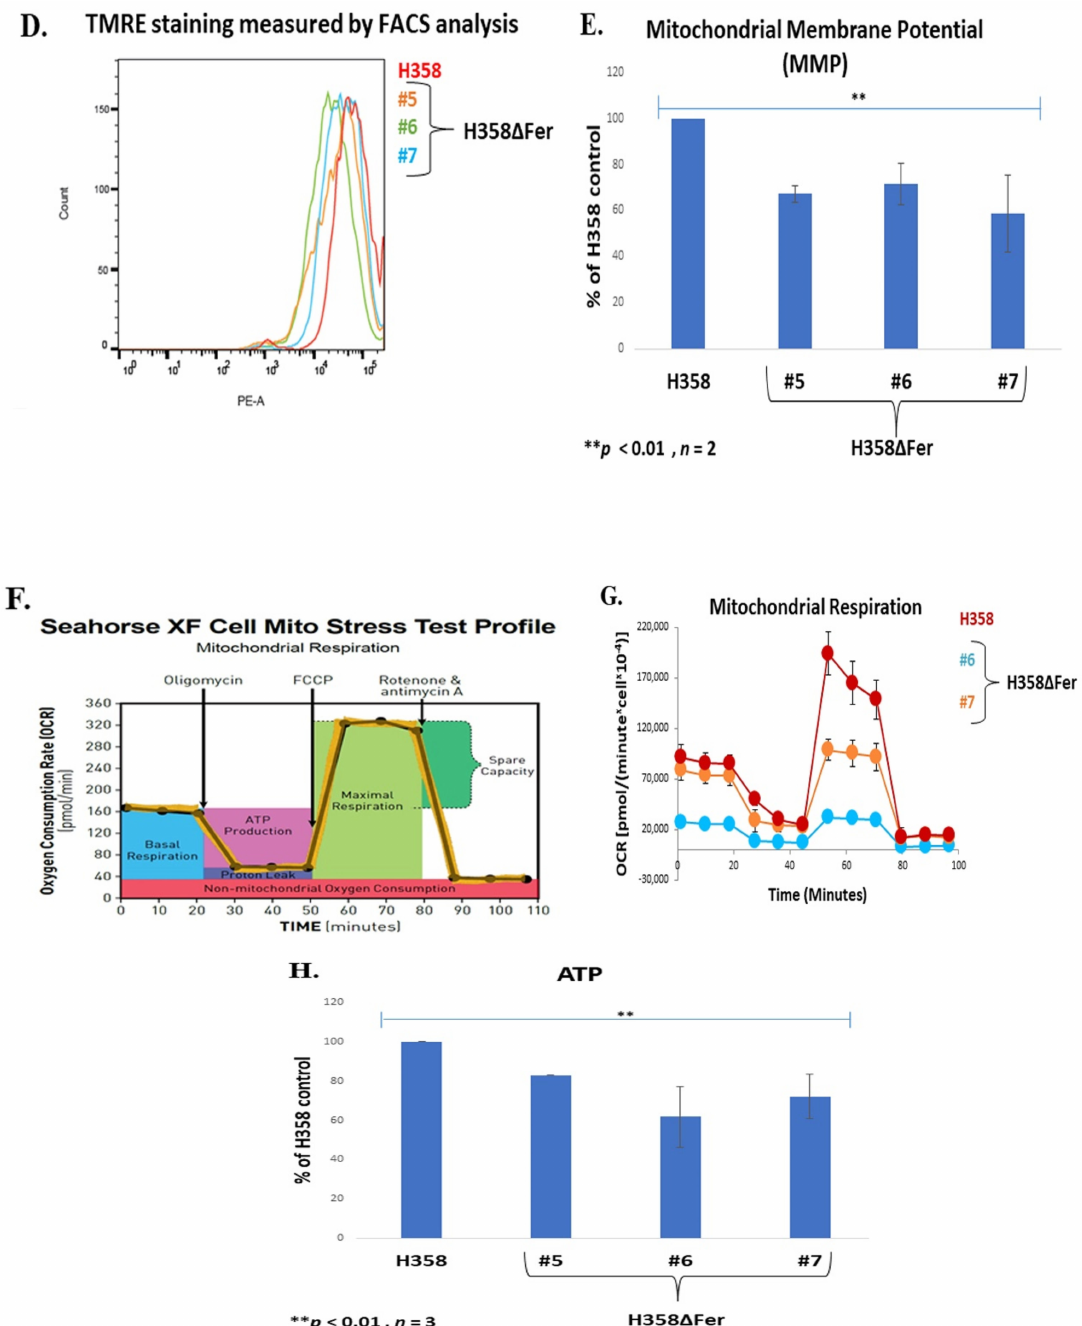
Figure 3. Impaired mitochondrial function in Fer-deficient H358 ∆ Fer cells. ( A ) Impaired comp. I activity in H358 ∆ Fer cells. Mitochondrial OXPHOS comp. I (NADH dehydrogenase) enzymatic activity. Results are presented as absorbance at OD 450 nm over time, and ( B ) reaction rates are presented as the slopes. ( C ) Reverse HPLC analysis of the NAD + levels in H358 and H358 ∆ Fer cells. These results represent one out of four independent experiments which gave similar results. ( D ) TMRE staining analysis measuring MMP, performed on H358 cells and H358 ∆ Fer clones #5, #6 and #7. TMRE staining intensity determined by FACS analysis. ( E ) Quantification of the results in ( D ), presented as % of the parental H358, Fer-expressing cells. ( F , G ) Mito-stress analysis evaluating mitochondrial respiratory capacity in H358 cells and two H358 ∆ Fer clones. ( G ) Shown is one out of three independent experiments which gave similar results. ( H ) LC-MS analysis of the ATP levels in H358 cells and H358 ∆ Fer clones. Results are presented as % difference from the H358 Fer parental cells. Histograms represent means +/ − SE. ** p -value <